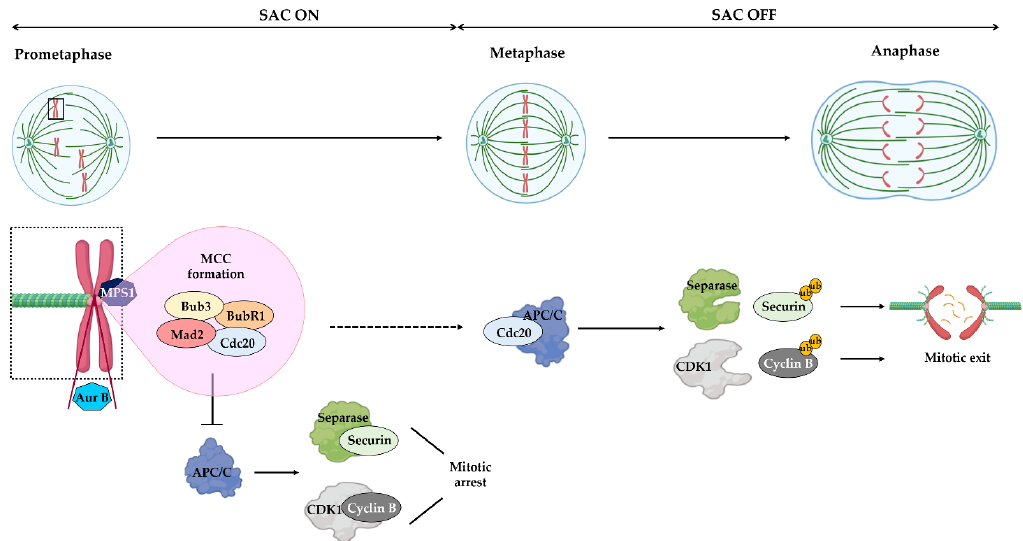
Figure 1. Spindle assembly checkpoint mechanism. In response to unattached or improperly at- tached kinetochores (prometaphase), the SAC is turned ON and promotes the assembly of the mitotic checkpoint complex (MCC), made of MAD2, BUB3, BUBR1 and CDC20. At these kineto- chores, the SAC kinase MPS1 recruits BUB3, BUB1 and BUBR1. The MCC inhibits the activity of anaphase-promoting complex/cyclosome (APC/C), leading to the stabilization of separase/securin and CDK1/cyclin B complexes and, consequently, mitotic arrest. The Aurora B kinase (AUR B), associated with centromere heterochromatin, promotes proper kinetochore–microtubule attachments. Once all chromosomes are properly attached to spindle microtubules and are aligned at metaphase plate (metaphase), the SAC is turned OFF, through MCC disassembly, and, consequently, CDC20 can bind and activate the APC/C, resulting in ubiquitylation (ub) of cyclin B and securin mitotic subtracts. In turn, separase can cleave cohesins to promote sister chromatid separation (anaphase), while CDK1 inactivation promotes exit from mitosis. Reprinted from [23], MDPI